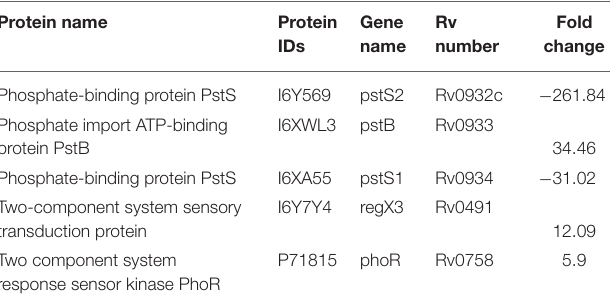
TABLE 1 | List of the differentially abundant proteins involved in the Pst system in M. tuberculosis lineage 7 (L7-35 and L7-28) vs. lineage 4 (H37Rv) strains.